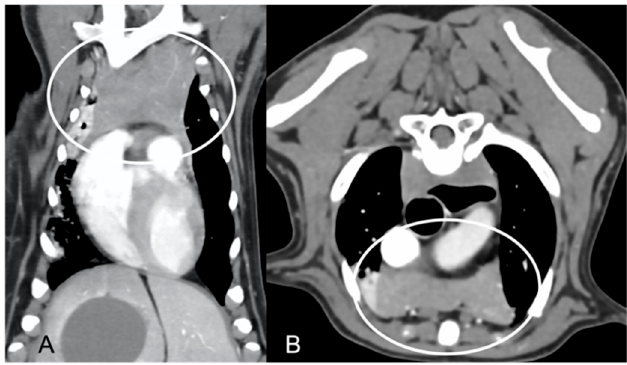
Figure 2. Example of a flattened thymus (circled) in a young dog. Post-contrast dorsal CT recon- struction ( A ) and transverse image ( B ) of the same patient. Note the flattened appearance of the thymus, enlarged in the laterolateral direction (width) and smaller in the dorsoventral direction (thickness).